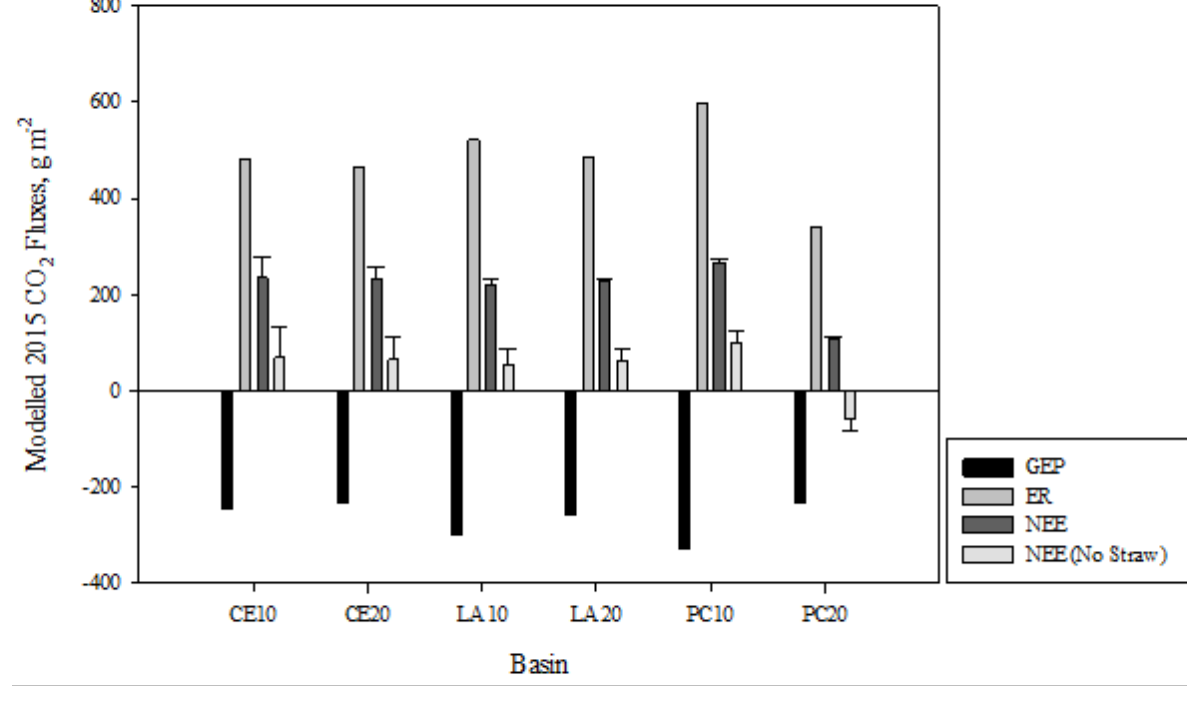
Figure 5. Modelled 2015 CO fluxes of each basin. Error bars were calculated for NEE 2